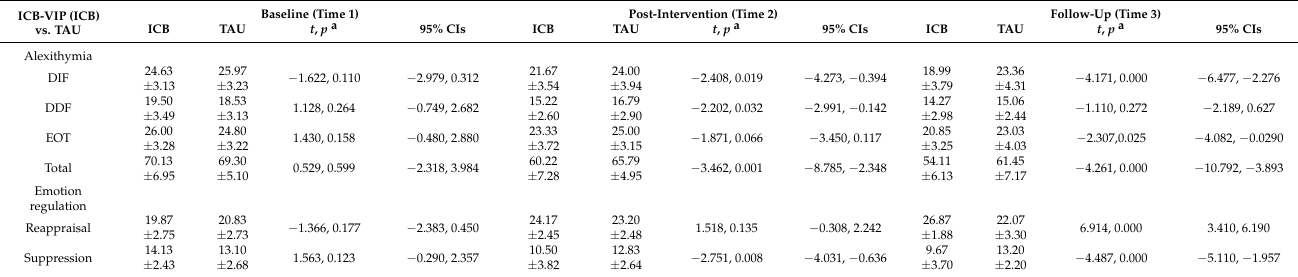
Table 4. Pre-post-intervention and follow-up data for social cognition and emotion regulation